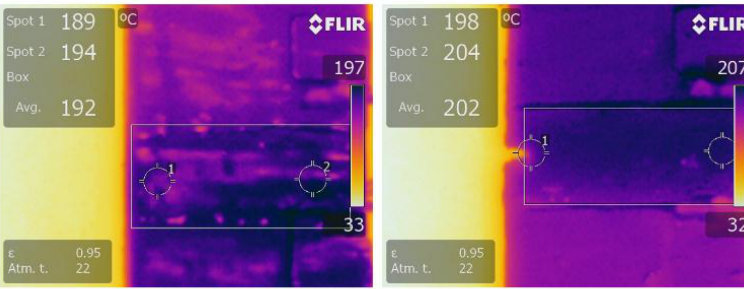
Figure 9. Thermal images of the shunt resistors ( a ) untrimmed and ( b ) trimmed with the square